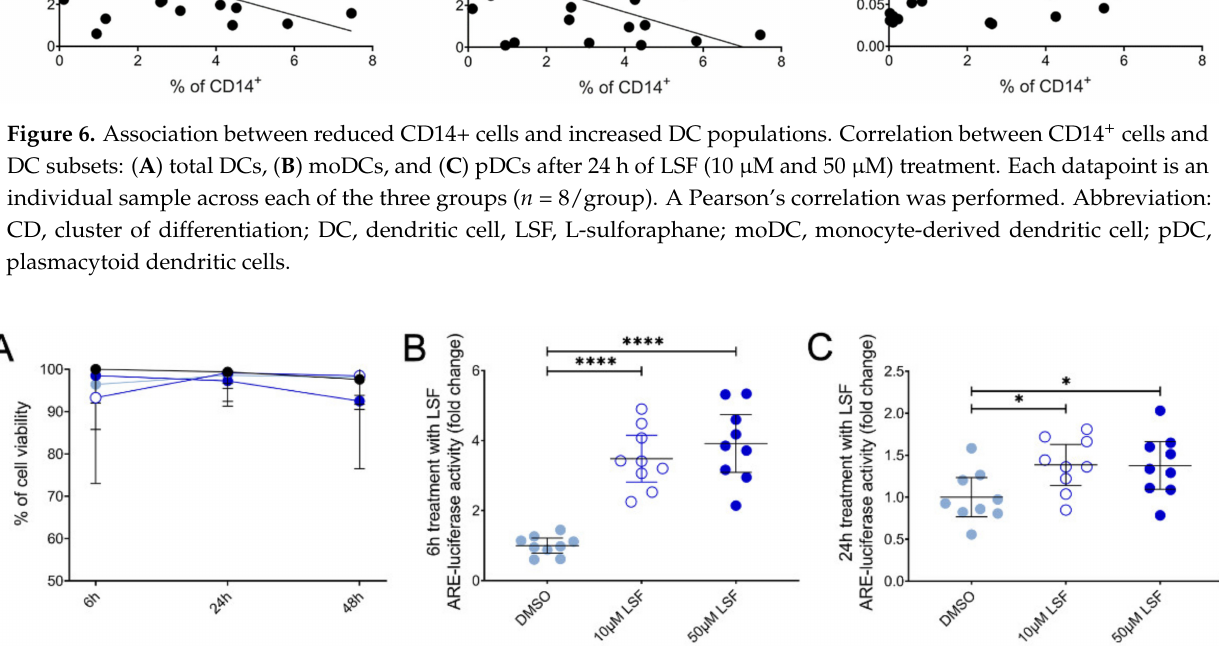
Figure 7. The effect of 10 µ M or 50 µ M LSF on Nrf2-ARE activity in THP-1 monocytes. Cell viability ( A ) and ARE-luciferase reporter activity after 6 h ( B ) and 24 h ( C ) of LSF treatment are shown. Data was collected as three independent experiments. The mean ± 95% CI are displayed. DMSO was used a vehicle control for LSF treatments. * p < 0.05, **** p < 0.0001 compared to the untreated DMSO control cells using the Student’s t -test. Legend: • Control, 10 µ M LSF, • 50 µ M LSF, • DMSO. Abbreviation: ARE, antioxidant response element; CI, confidence interval; DMSO; dimethyl sulfoxide; LSF,